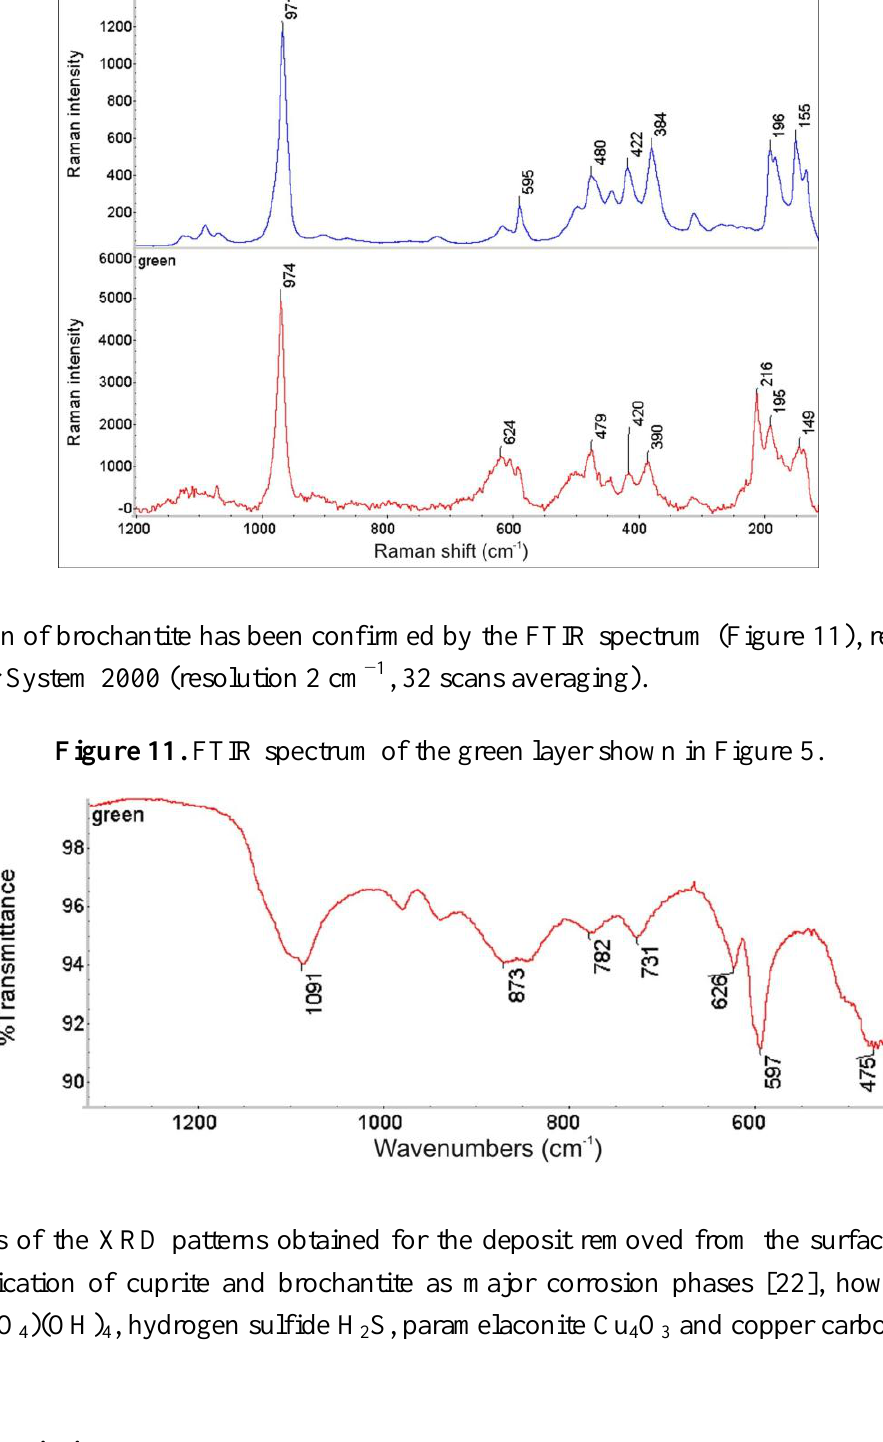
SO (OH) (upper plot) 4 4 6